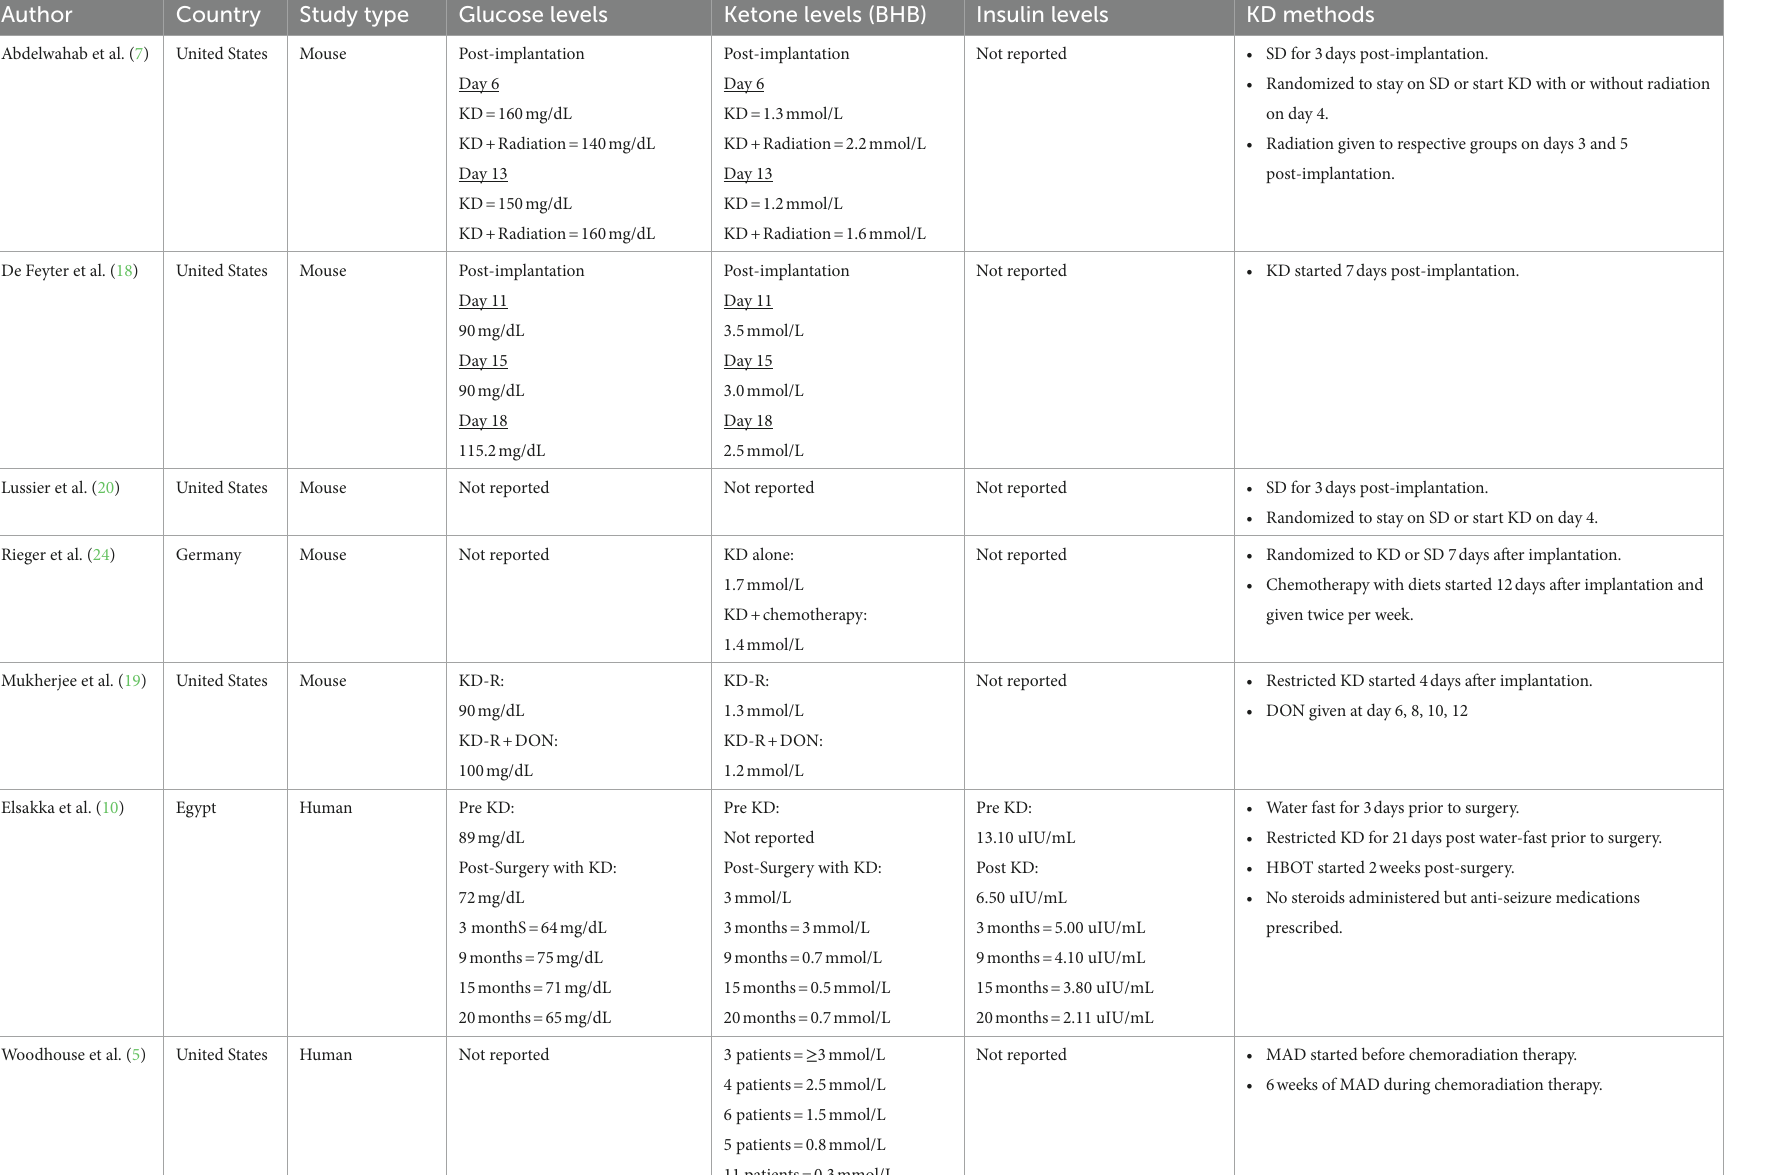
TABLE 3 Glucose, ketone, and insulin levels while using the KD in treating